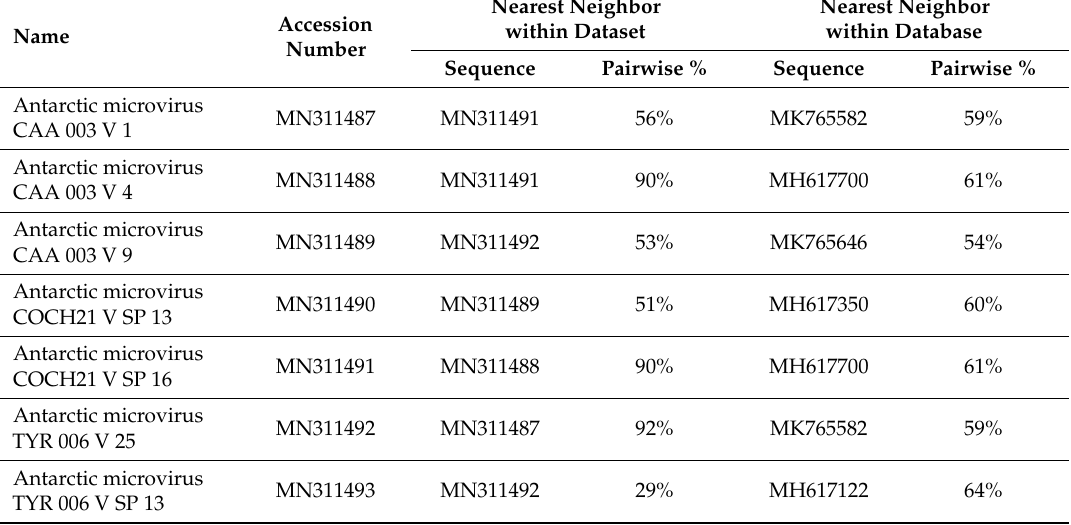
Table 4. Pairwise amino acid sequence identities of the major capsid proteins (MCPs) of microviruses identified in this study, with each nearest match within this dataset, and those of viral sequences in GenBank. The pairwise identities were determined using SDT v1.2